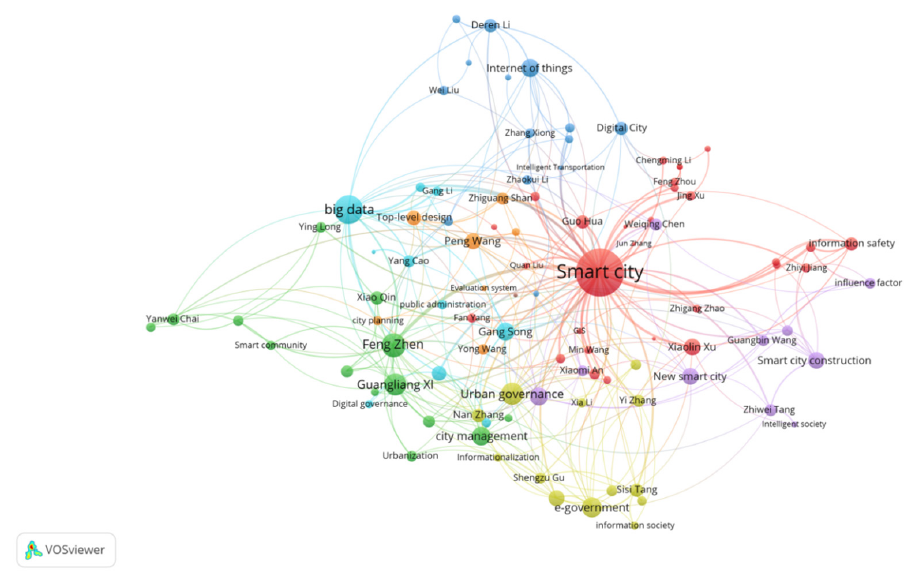
Figure 3. Co-occurrence atlas of authors and keywords.